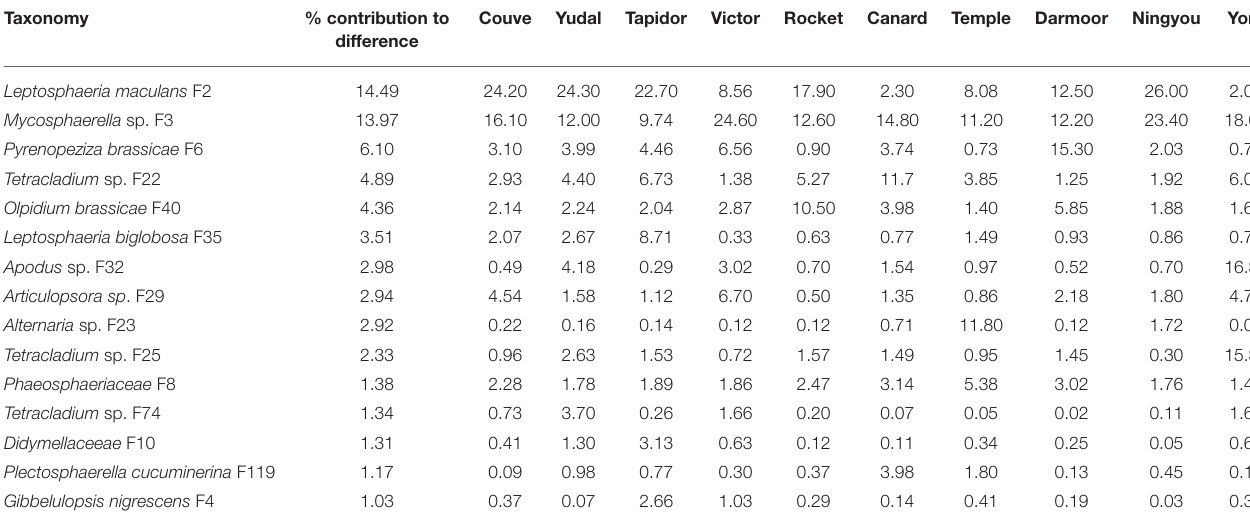
TABLE 4 | Analysis of similarity percentage (SIMPER) of differences in oilseed rape rhizosphere fungal OTU between oilseed rape genotypes (high and low nitrogen treatments combined). Taxonomy % contribution to difference